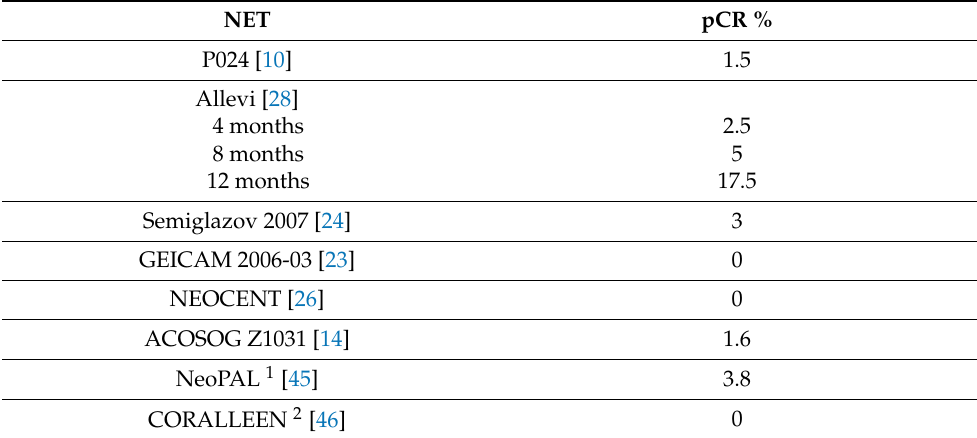
Table 3. Pathological complete response (pCR) rates after 3 to 12 months of